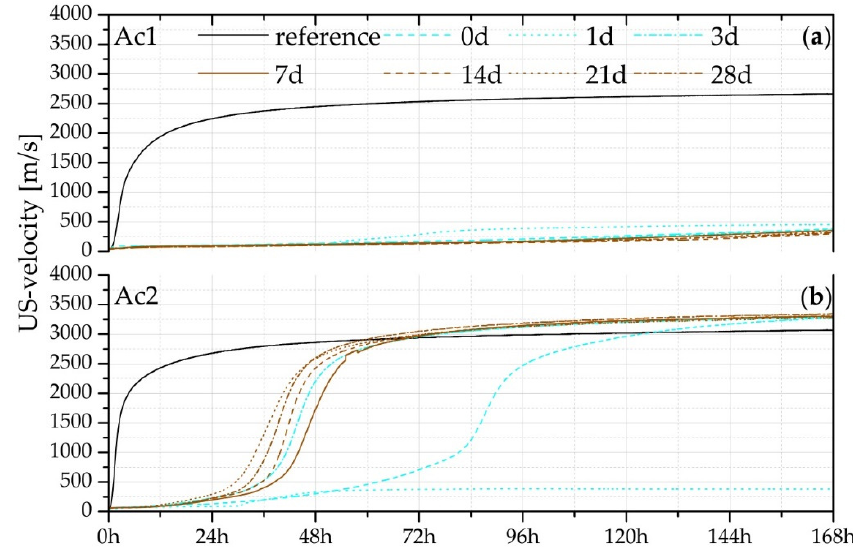
Figure 2. Average of US-velocity measurement of the references (without retarder) and the reactivated mixtures with ( a ) Ac1, and ( b ) Ac2 after seven different periods of retardation with 1%R.